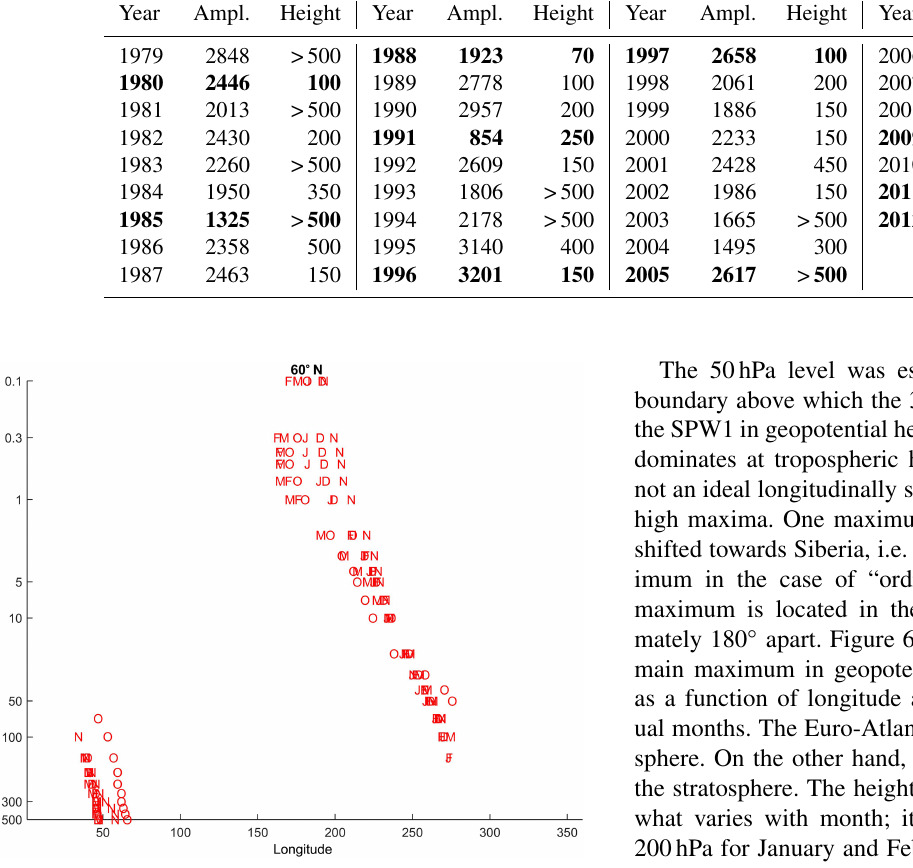
Figure 6. Position of the SPW main maximum in geopotential heights at 60 ◦ N as a function of longitude and pressure height for individual months, October to March (marked O, N, D, J, F,